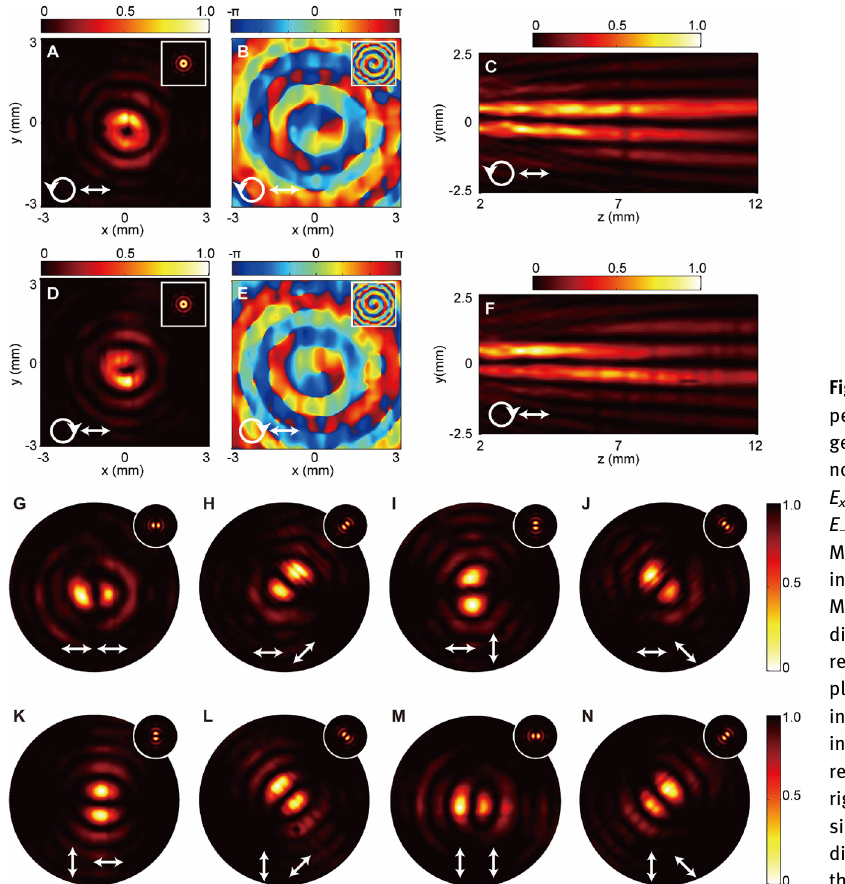
Figure 5: Experimental and simulated performance of the metasurface VBB generator. (A, D, G – N) Measured normalized intensity distributions of E xL , E xR , E xx , E 45 ° x , E yx , E − 45 ° x , E xy , E 45 ° y , E yy , and E − 45 ° y in the xy plane, respectively. (B, E) Measured phase distributions of E xL and E xR in the xy plane, respectively. (C, F) Measured normalized intensity distributions of E xL and E xR in the yz plane, respectively. All the measured results are plotted at 1.1 THz. The former and latter inset arrows in the bottom indicate the input and detect polarizations, respectively. The inset fi gures in the top- right positions are the corresponding simulated normalized intensity and phase distributions at 1.0 THz. The diameters of the circles in (G – N) are all 6